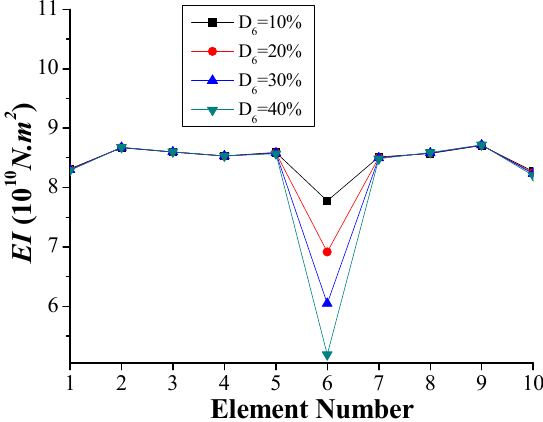
Figure 13. Simulation results of calculated EI for a single damage (Scenario 1).